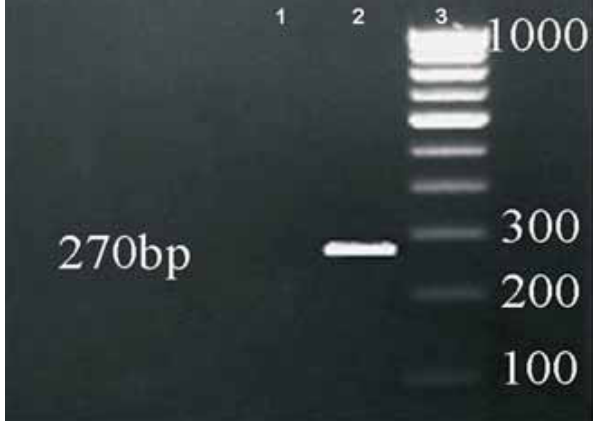
Figure-4: Screening of field isolates for detection of Staphylococci aureus using species specific primers targeting the thermonuclease gene (nuc gene). Lane 1: Negative isolate, Lane 2: Positive isolate, Lane 3: DNA